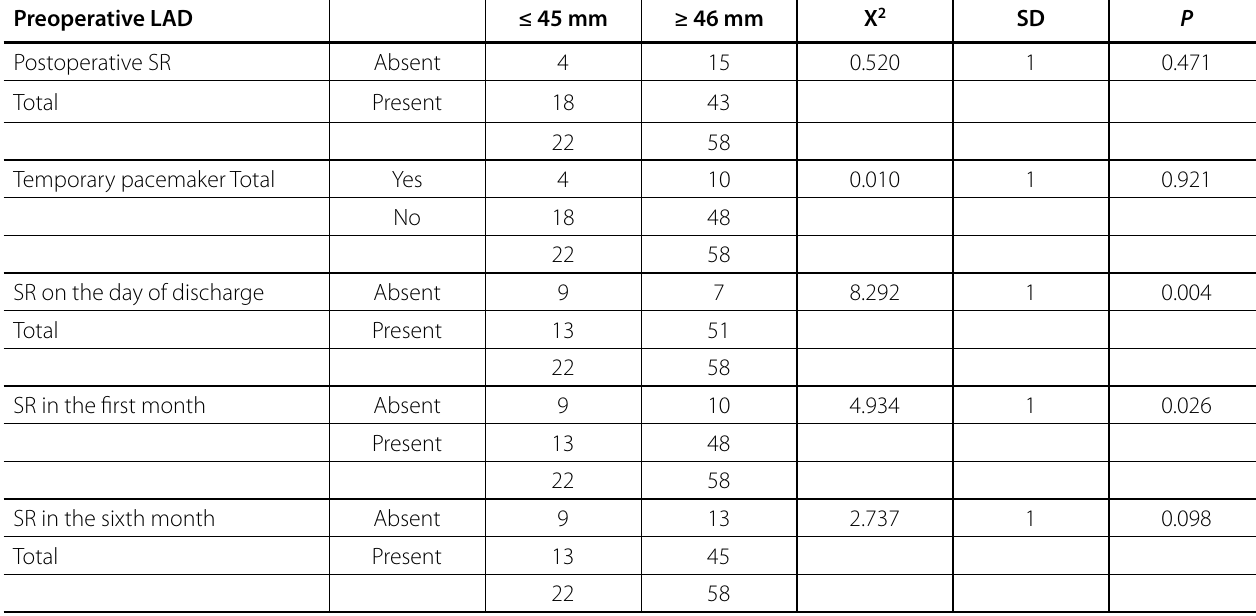
Table 5 . Comparison between two groups of patients (preoperative LAD ≤ 45 mm in one group and ≥ 46 mm in another group). Preoperative